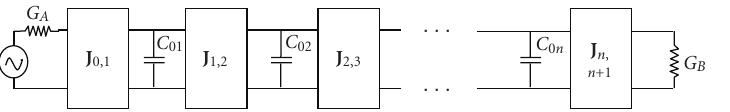
Figure 1: LPF prototype based on shunt capacitors and admittance inverters.